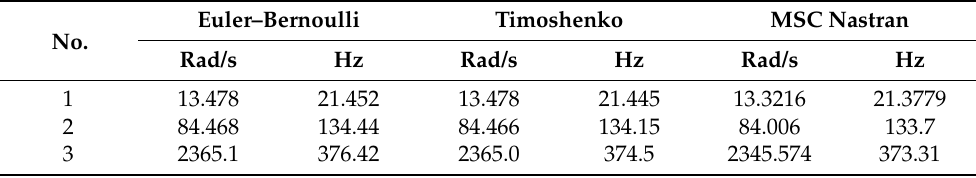
Table 2. Frequencies obtained by Euler–Bernoulli and Timoshenko beam theories and MSC Nastran. Euler–Bernoulli Timoshenko MSC Nastran No. Rad/s Hz Rad/s Hz Rad/s Hz 1 13.478 21.452 13.478 21.445 13.3216 21.3779 84.468 134.44